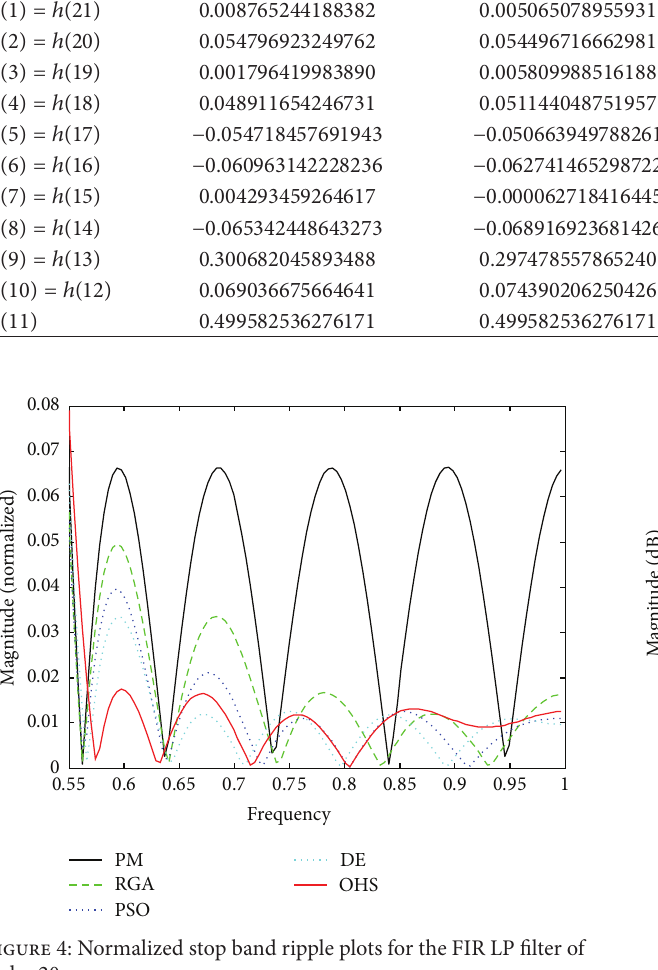
Figure 5: dB plots for the FIR HP filter of order